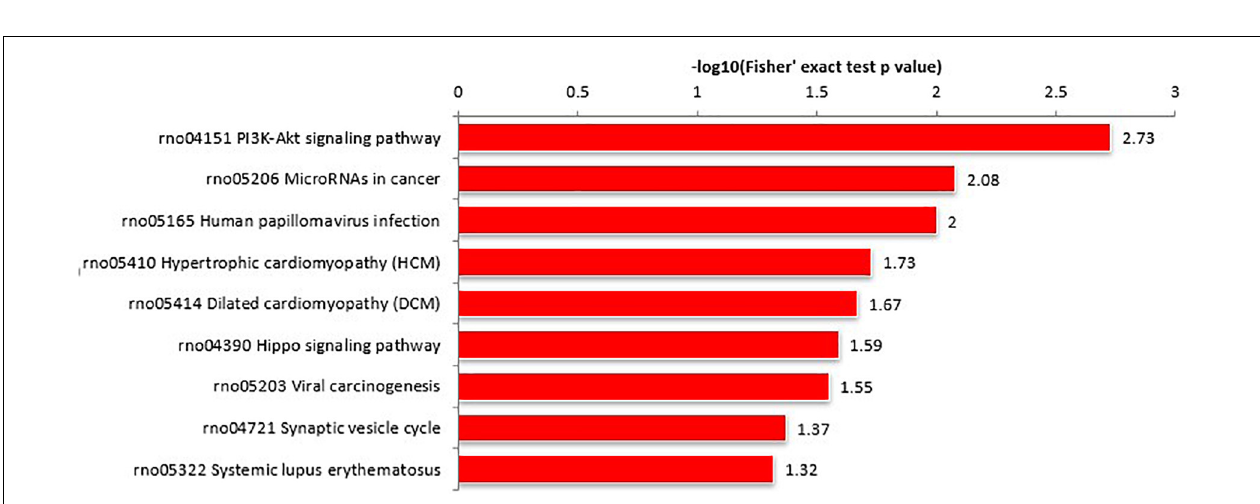
Frontiers in Neuroscience |